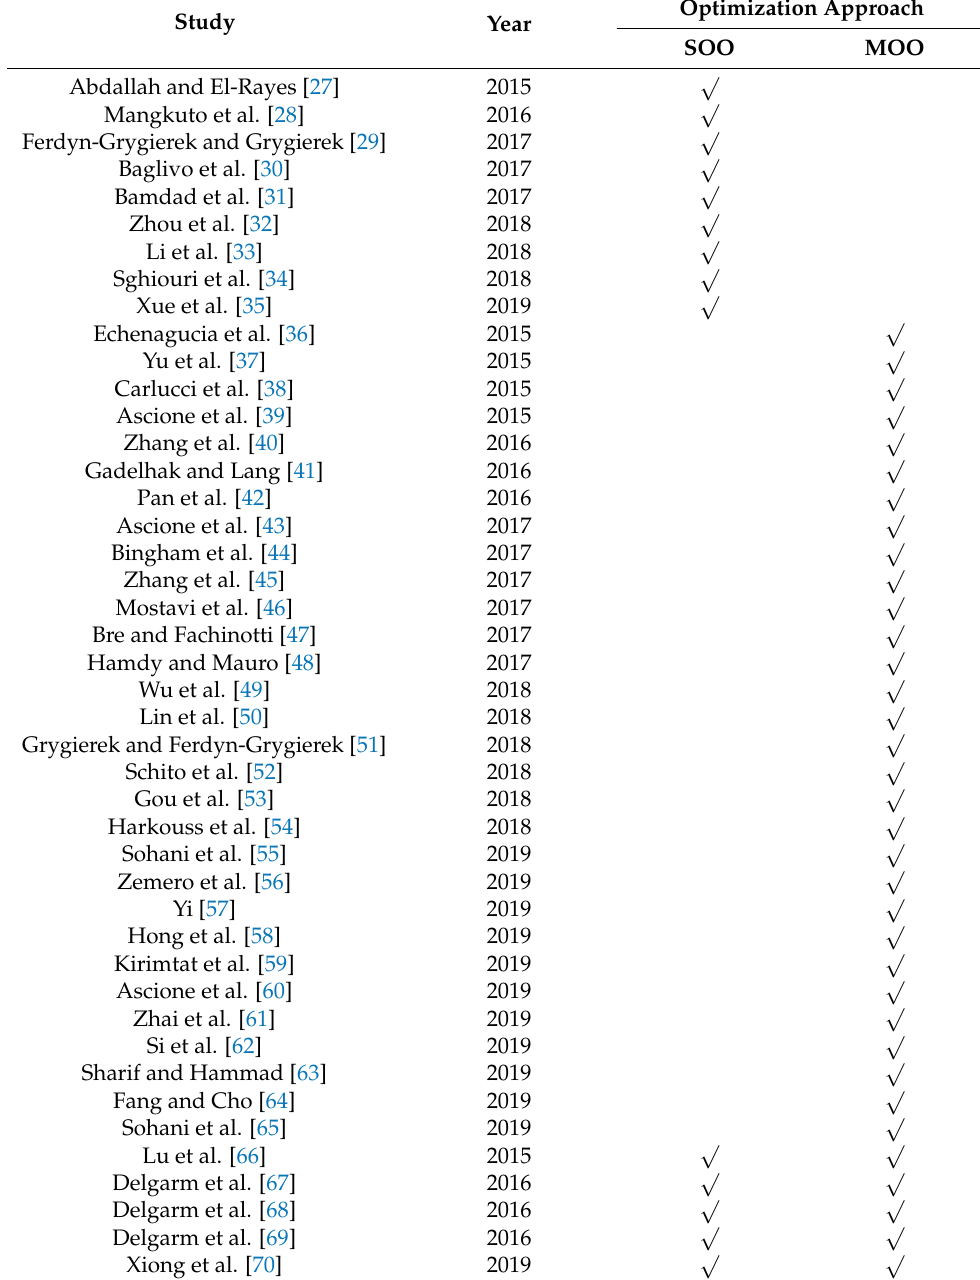
Table 2. The core